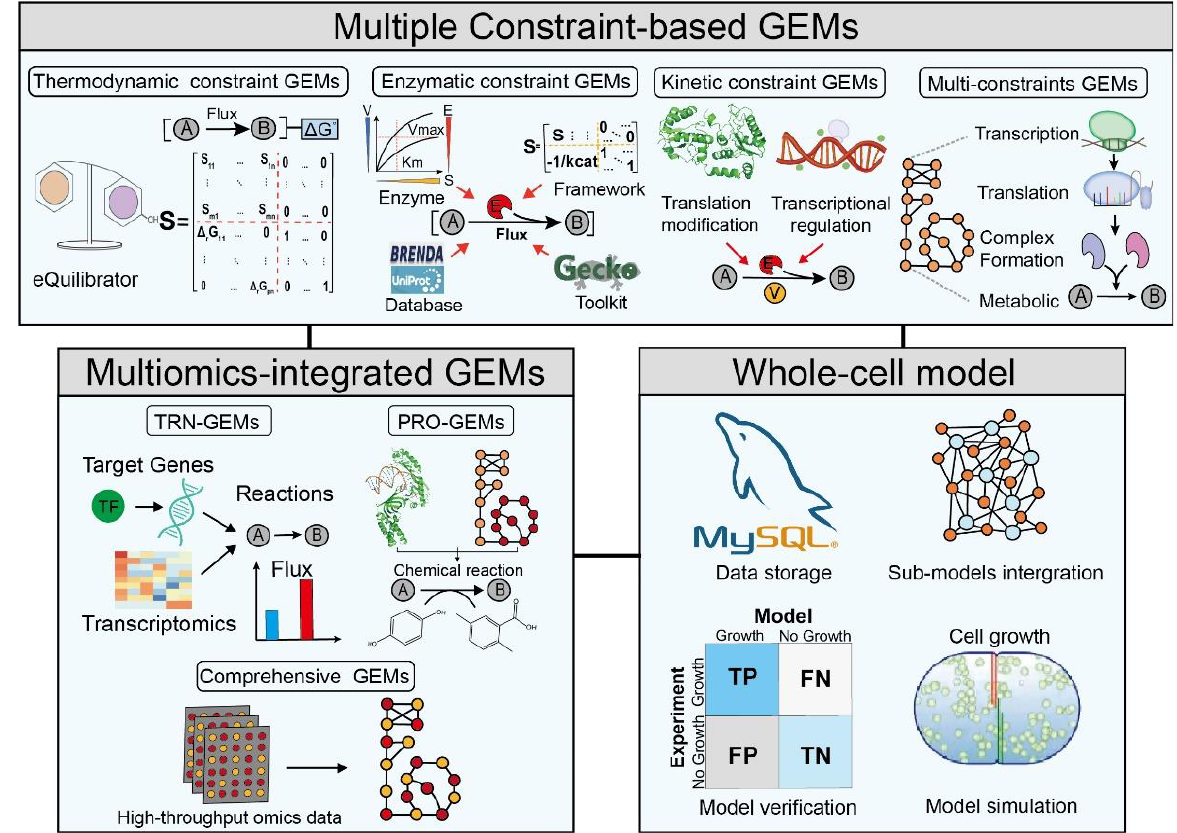
Figure 2. The main classification and construction framework of multiscale GEMs.